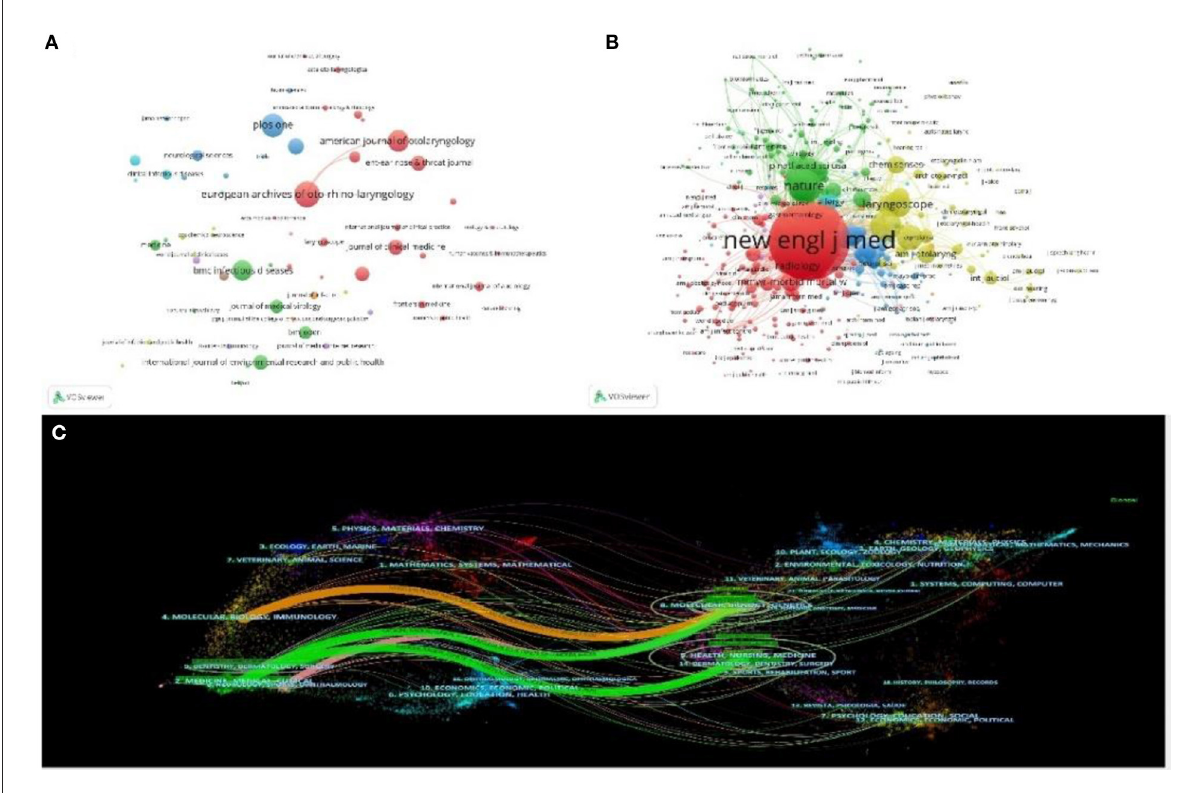
FIGURE6 Visual map analysis of the network relationship map of published (A) and cited magazines (B) in COVID-19-related otorhinolaryngology research. (C) The dual-map overlay of journals contributed to publications on COVID-19-related otorhinolaryngology research.